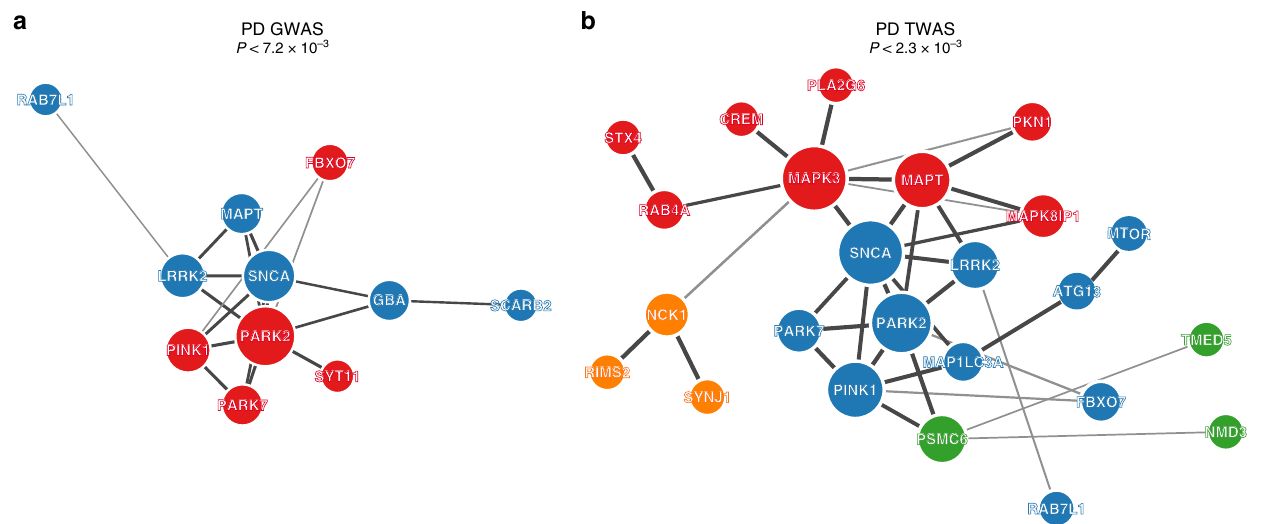
Fig. 4 Proteins nominated by Parkinson ’ s disease transcriptome-wide association study (PD TWAS) form expanded protein-protein interaction (PPI) and are enriched in the lysosomal pathway. a The PPI network connectivity are statistically signi fi cant ( p < 7.2 × 10 − 3 ) and form two communities (represented by blue and red nodes). b We also applied GeNets to evaluate PPI network connectivity between protein products nominated by PD TWAS and monogenic genes. We found that they form a signi fi cantly expanded PPI ( p < 2.3 × 10 − 3 ) network with known PD genes with four communities (represented by blue, green, orange, and red